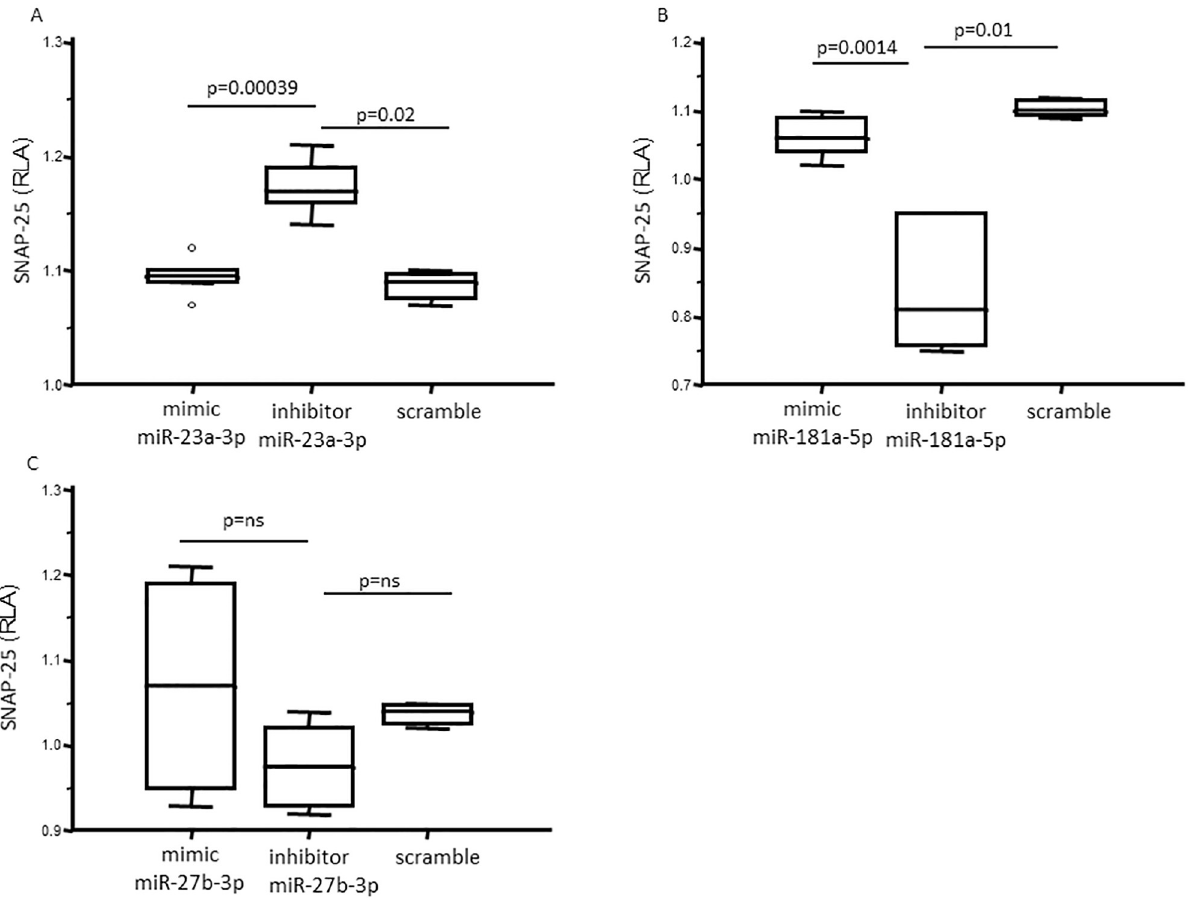
Fig 1. Relative luciferase activity (RLA) in Vero cells. Different transfection experiments were performed independently with miRNA mimic, or miRNA inhibitor or scramble control. Each experiment was repeated at least 3 times and conducted in triplicate; the results presented in the figures indicate the median values obtained and 25 th -75 th percentile. RLA were measured in Vero cells 24 hours after transfection with (a) miR-23a-3p mimic, or inhibitor, or scramble negative control; (b) miR-181a-5p mimic, or inhibitor or scramble negative control; (c) miR-27b-3p mimic, or inhibitor or scramble negative control. RLA of cells transfected with miR-23a-3p inhibitor was significantly higher compared to that observed in cells transfected with miR-23a-3p mimic or scramble negative control; RLA of cells transfected with miR-181a-5p was significantly lower compared to that observed in cells transfected with miR-181a-5p mimic or scramble negative control. No differences were observed regarding miR-27b-3p mimic or inhibitor transfection. ns: not significative.